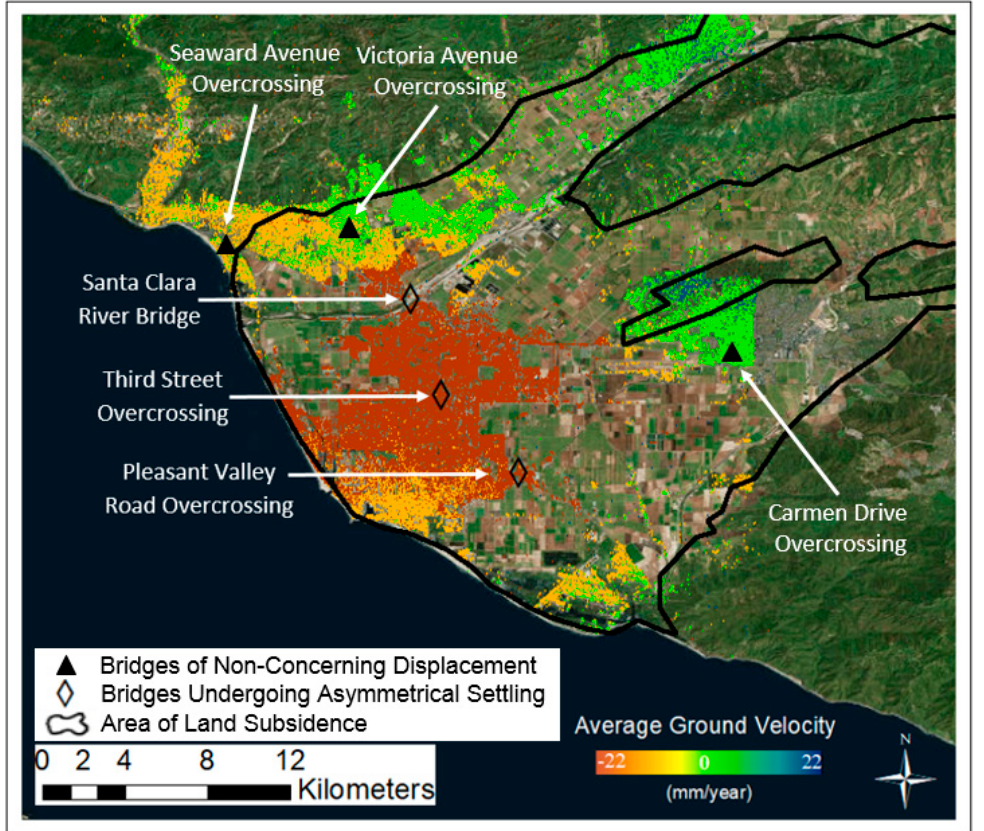
Figure 3. Regional displacement velocity map, made using ArcGIS. Colored scale indicates the average ground displacement velocity across Oxnard, CA. White arrows indicate the bridges of focus. The area within the black line is the area experiencing land subsidence.